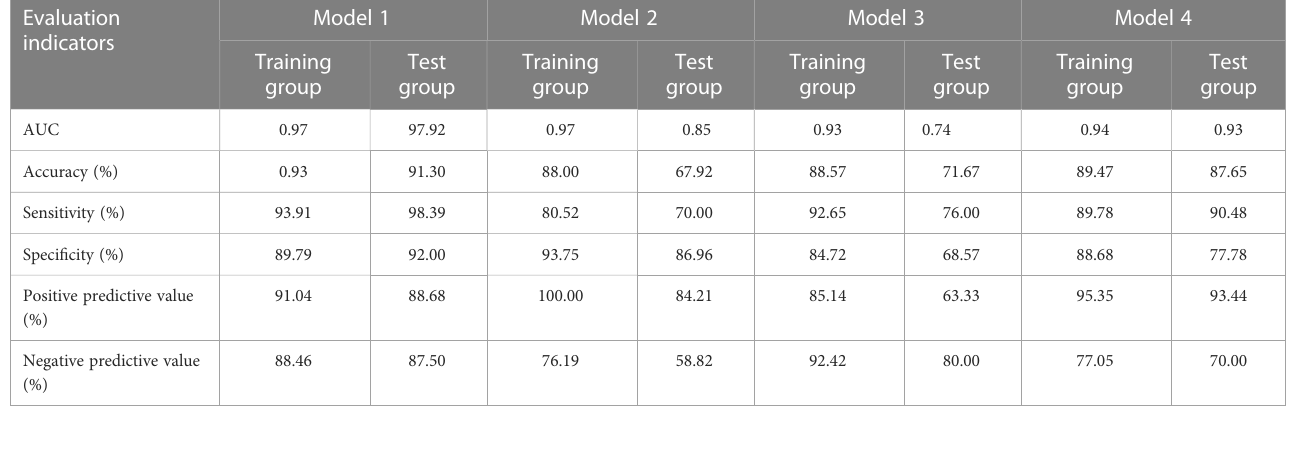
TABLE 2 Diagnostic ef fi cacy of the radiomics models of models 1-4.